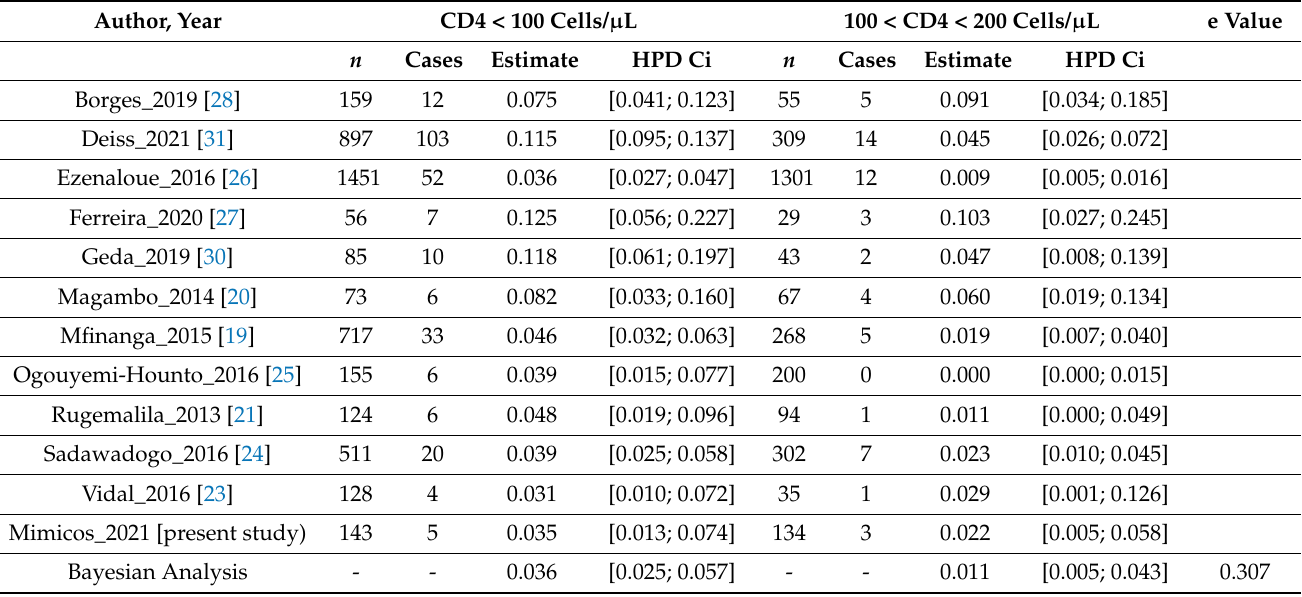
Table 4. Studies included in the prior and posterior distribution for Bayesian analysis regarding